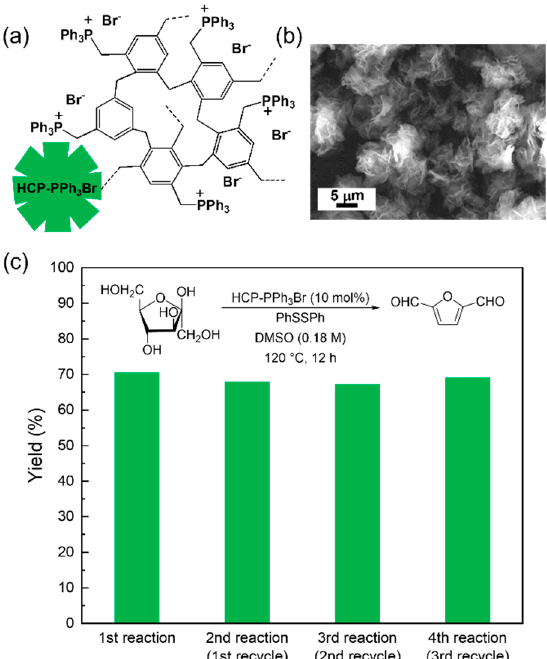
Figure 3. ( a ) Structure of HCP-PPh 3 Br, ( b ) SEM image of HCP-PPh 3 Br, ( c ) the yield of each recycling experiment.